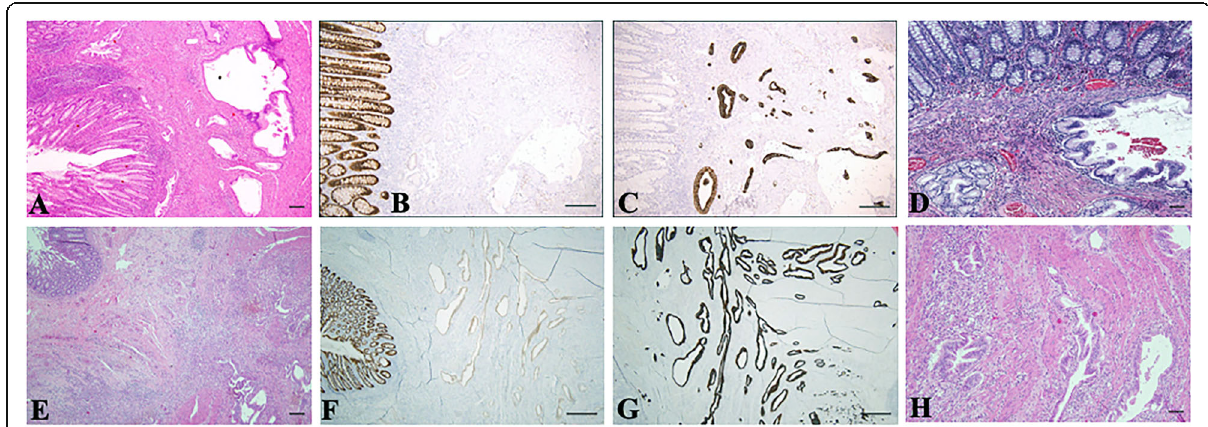
Fig. 1 Case of a 74-year-old male. a Well differentiated pancreatic ductal adenocarcinoma near dilated, pancreatic gland in the bowel wall exhibiting architectural and cytologic atypia [hematoxylin and eosin (H&E) stain; 4×]. b Tumor cells are negative for CDX2 in neoplastic glands, compared to normally immunoreactive colonic mucosa (10×). c Complementary CK7 positivity of neoplastic glands and negativity of the non- neoplastic colonic mucosa (10×). d Atypical pancreatic glands close to normal pancreatic glands (H&E stain; 4×). Case of a 78-year-old female. e Well differentiated pancreatic ductal adenocarcinoma near to the pancreatic gland in the bowel wall (H&E stain; 4×). f Immunohistochemistry (IHC) shows negativity for CDX2 in neoplastic glands associated to positivity in the normal colonic mucosa (10×). g IHC shows positivity for CK7 in neoplastic glands associated to negativity in the normal colonic mucosa (10×). h Dysplastic pancreatic glands (H&E stain; 4×). Scale bars 100 μ